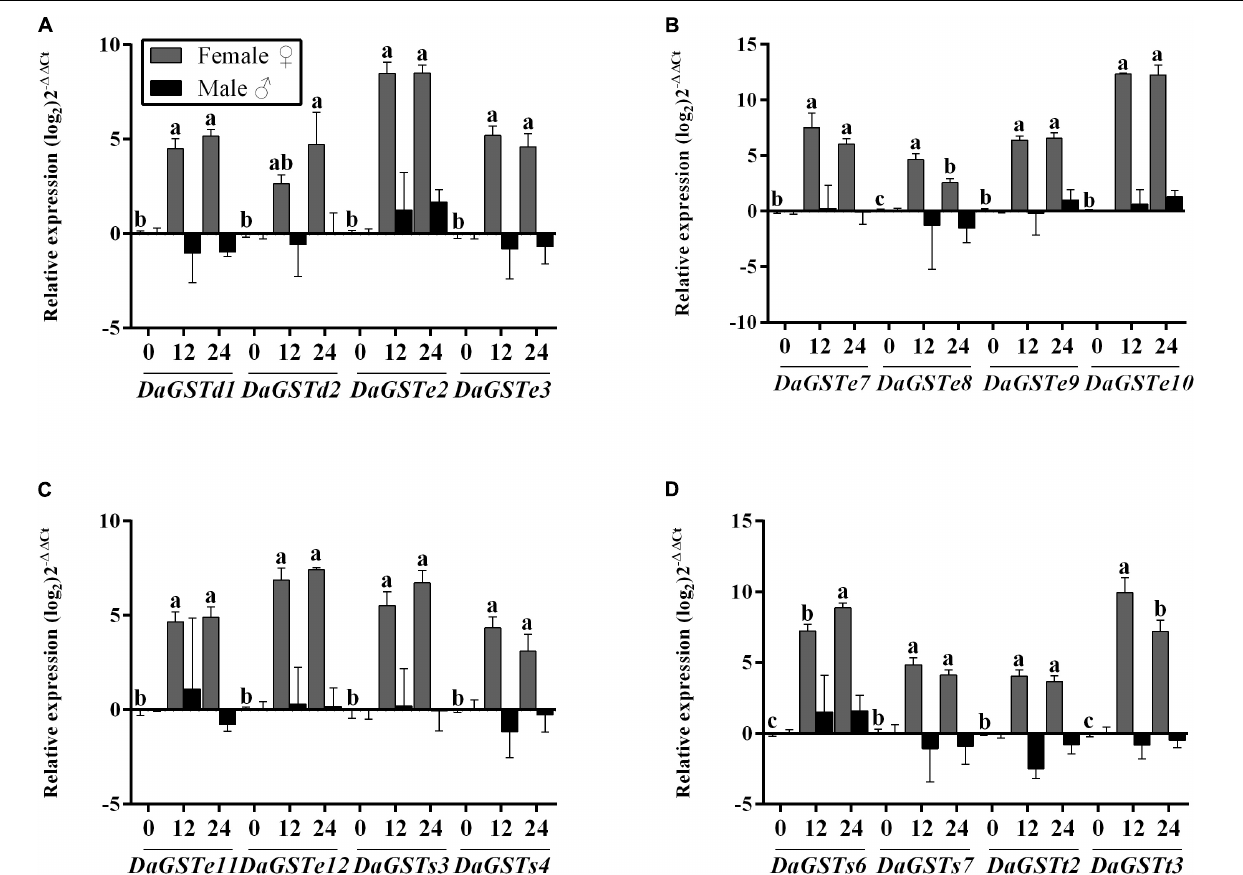
FIGURE 4 | Quantitative transcript levels of GST genes (mean ± SE, n = 3) in feeding adults (12 and 24 h) of Dendroctonus armandi . GST expression was normalized to the transcription level geometric mean of β - actin and CYP4G55 . Different letters indicate significant differences at P < 0.05 (with Tukey test, lowercase for females and uppercase for males, no letter means no significant difference among times). Statistically significant differences in gene expression are shown in Supplementary Table S3